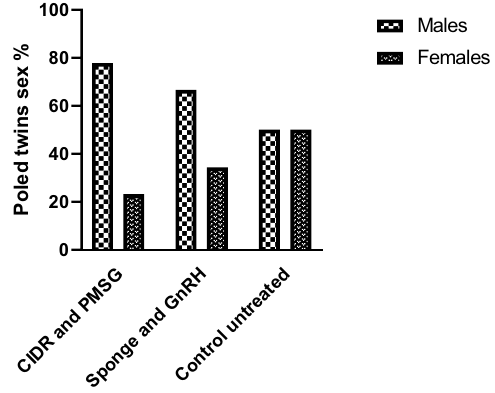
Figure 2: Twining productionofthe three treated ewes groups ( CIDR + PMSG, Sponge + GnRH, and control ) and sex preselection rate. Figure 3: Total male and female twining production and their sex preselection rate of the three treated ewes groups ( CIDR + PMSG, Sponge + GnRH, and control ) .